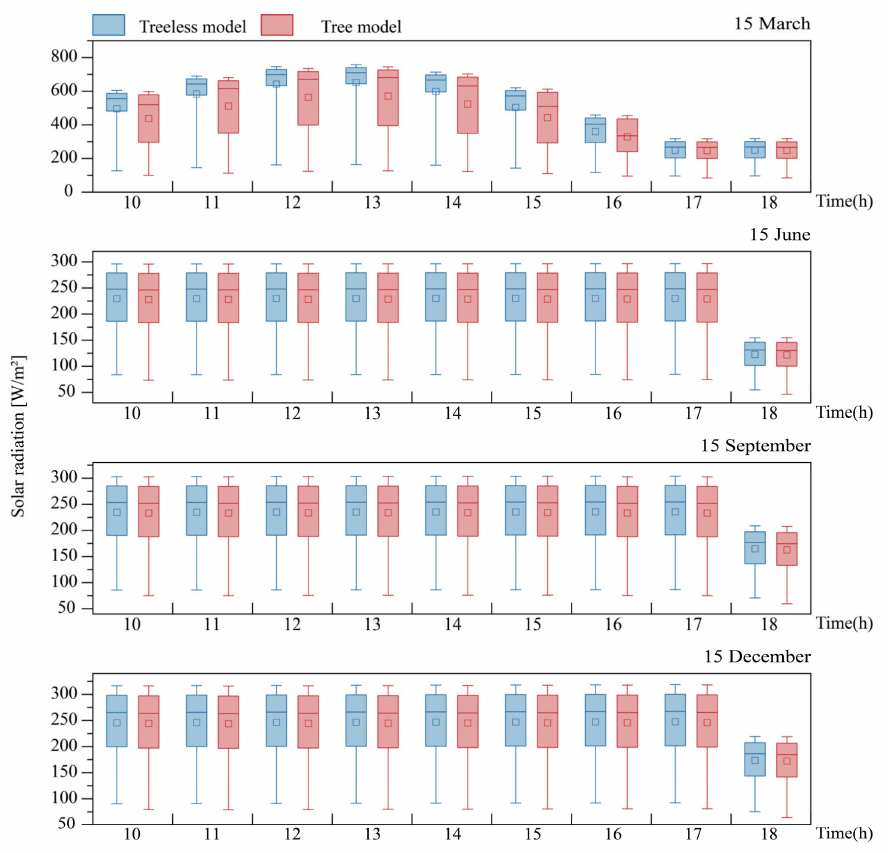
Figure 6. Comparison of the range of solar radiation between two models at a height of 1.2 m on four